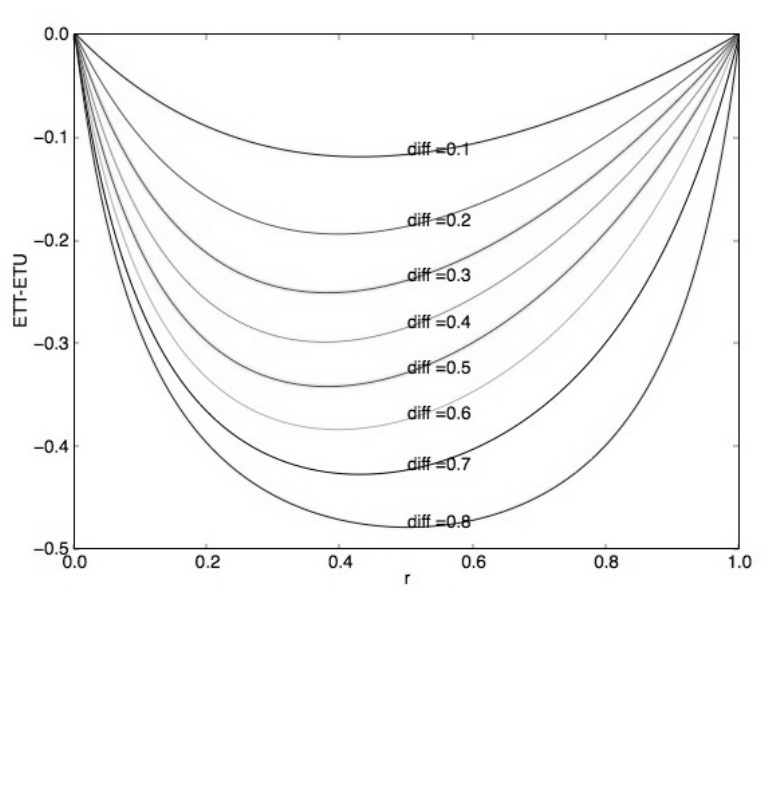
Figure 4: ET T − ET U vs. r for different levels of enrollment disparity, q